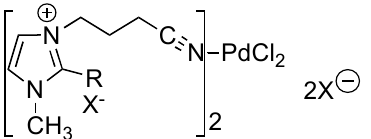
Figure 6. Coordination of the nitrile group to the palladium center